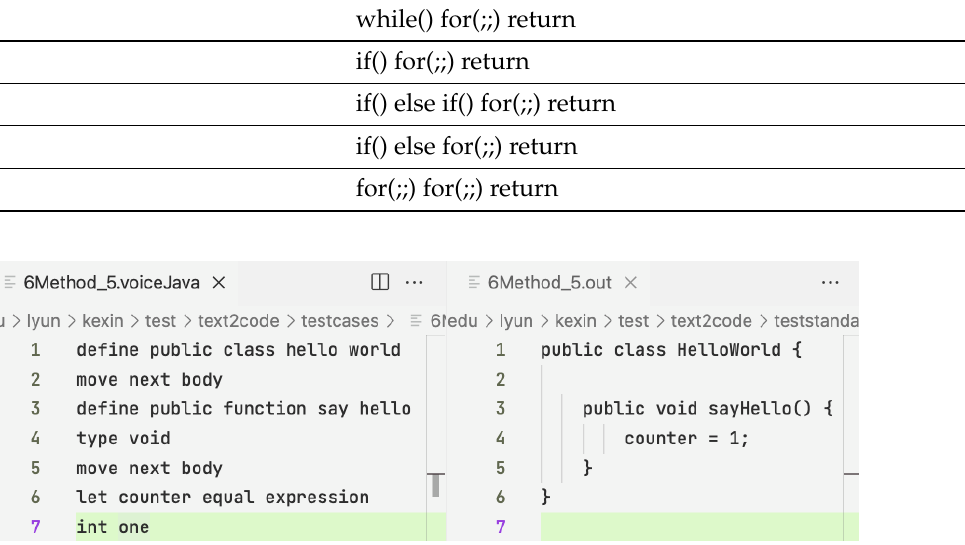
Table 1. The possibilities for a for-loop.